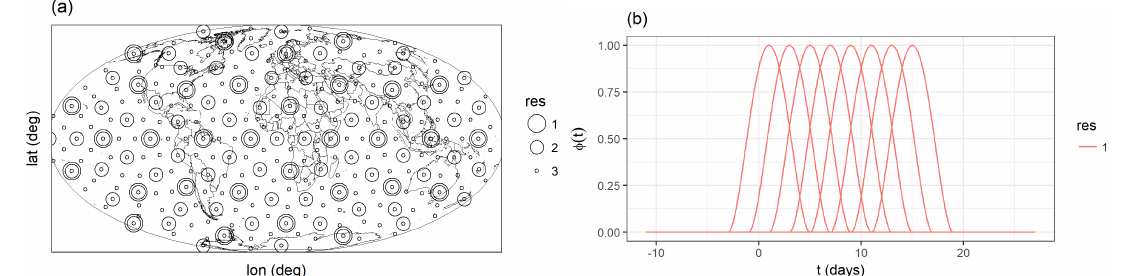
Figure 7. Spatio-temporal basis functions constructed by taking the tensor product of spatial and temporal basis functions. ( a ) The spatial basis functions used are bisquares over three different resolutions. The circle denotes the centroid of the bisquare while the circle size denotes the resolution (smaller indicates a finer resolution and hence a smaller aperture). ( b ) The temporal basis functions used were bisquares with centroids regularly placed between zero and 16 days in the moving